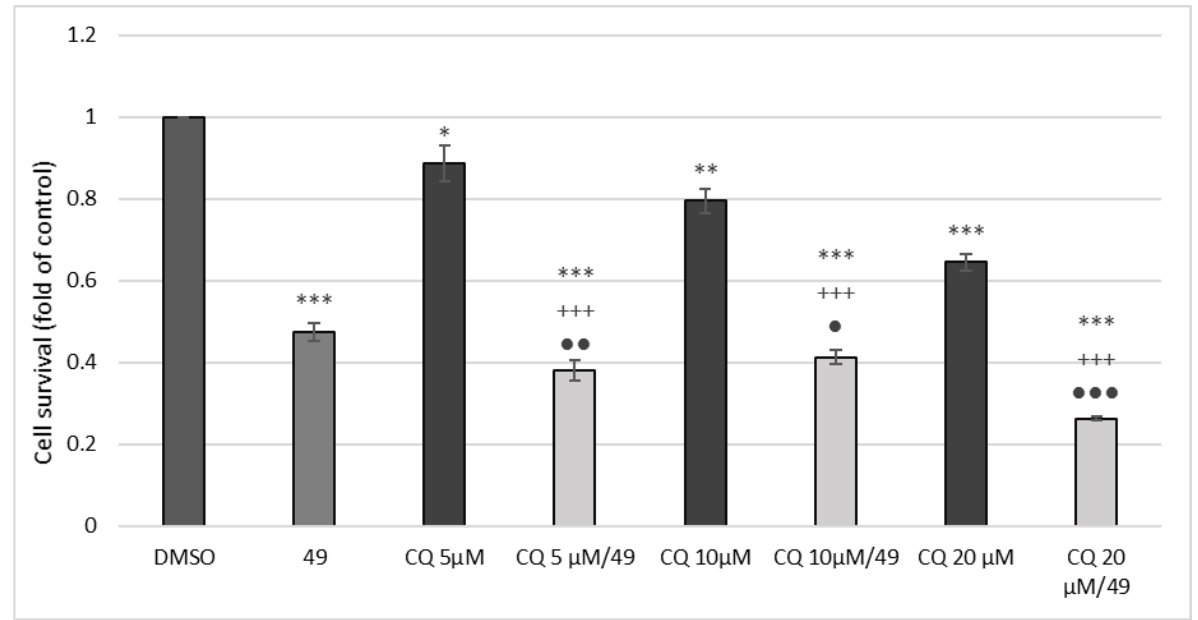
Figure 6. Effect of chloroquine (CQ) on A549 cell survival either alone or in combination with compound 49 (20 μM). The data show the mean ± SD values of three independent experiments. Statistical significance: * p < 0.05, ** p < 0.01, *** p < 0.001 vs. DMSO, +++ p < 0.001 vs. CQ, ● p < 0.05 vs. 49 , ●● p < 0.01 vs. 49 , ●●● p < 0.001 vs. 49 .